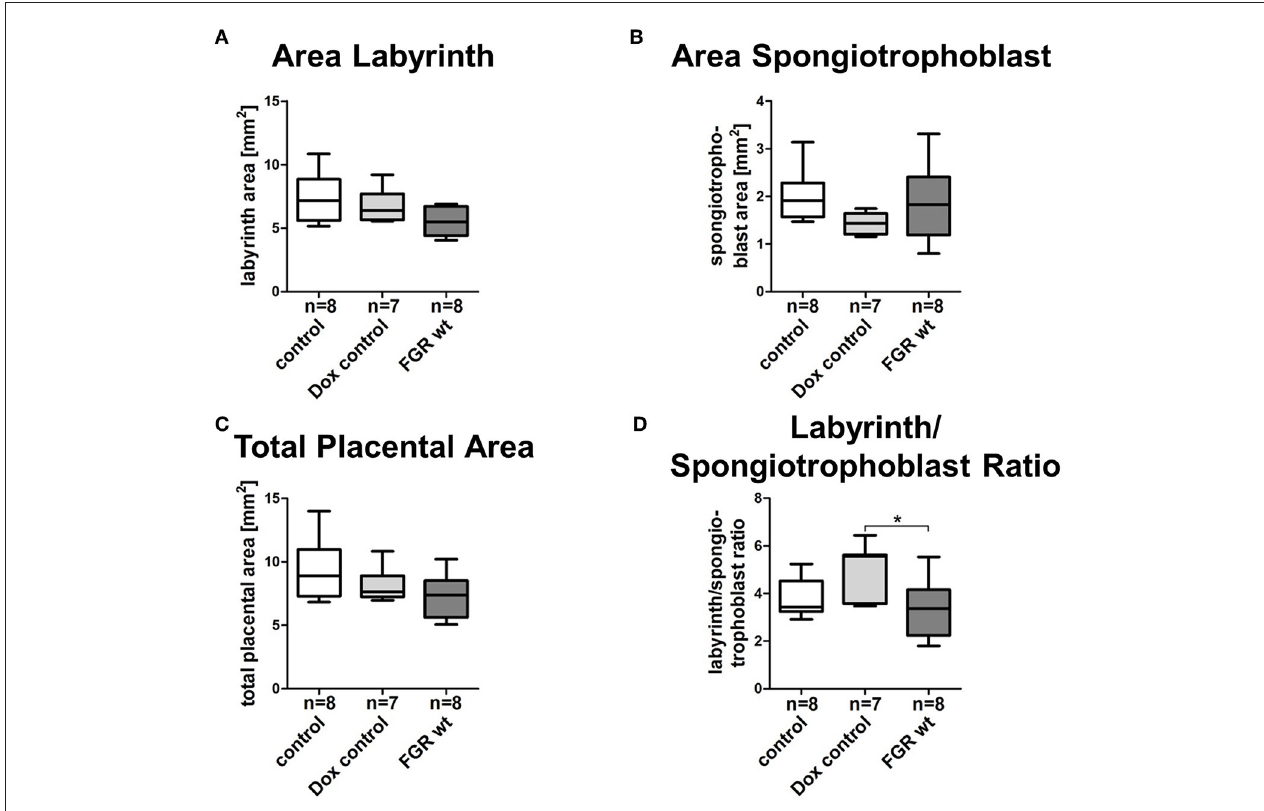
FIGURE 5 | Morphometric analysis of placentas in the hsFLT1/rtTA mouse model. Analysis of the labyrinthine (A) , spongiotrophoblast (B) , and total placental area (C) as well as labyrinth to spongiotrophoblast area ratio (D) of human soluble fms-like tyrosine kinase 1 (hsFLT1) expressing fetal growth restriction wild-type placentas (FGR wt; n = 8), compared to control ( n = 8), and doxycycline (Dox) control ( n = 7) placentas. FGR wt placentas showed slight reduction in labyrinth and total placental area and labyrinth to spongiotrophoblast ratio compared to both control groups, whereas spongiotrophoblast area was slightly increased. Data is presented in box and whisker plot. * p < 0.05 as determined by the Kruskal–Wallis test with Dunn’s post hoc